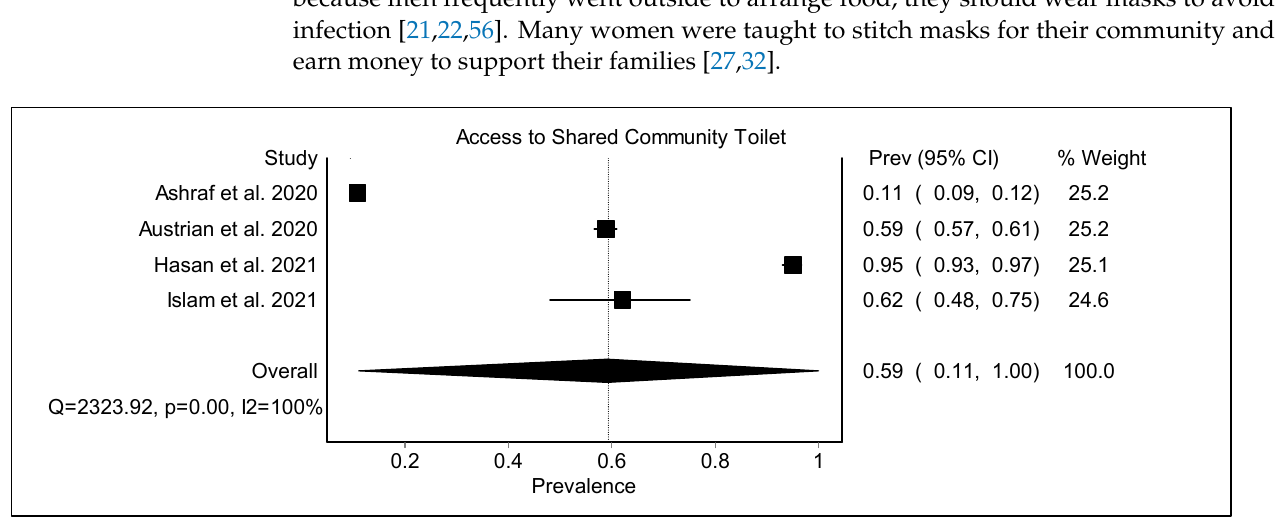
Figure 4. The pooled prevalence of access to shared community toilets among urban poor [25,49,51,52].